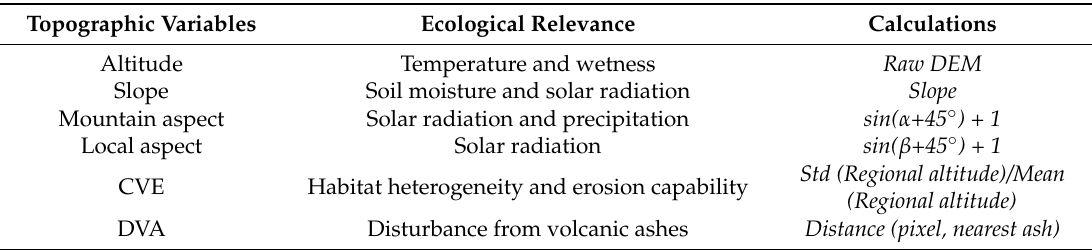
Table 2. Topographic variables and ecological